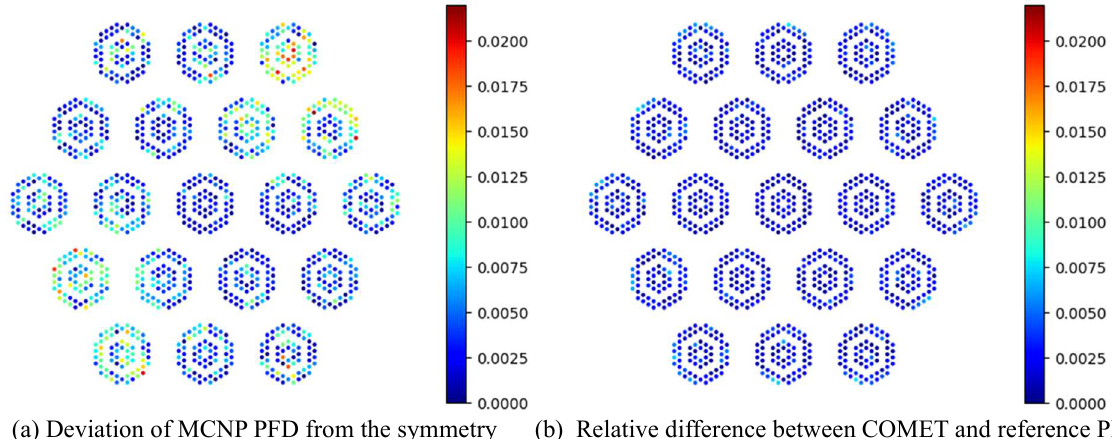
Figure 5. Comparison of the PFD distribution for the ARI